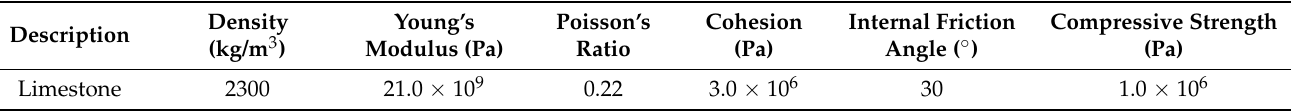
Table 2. Structural plane parameters taken as references for the stability calculation model.